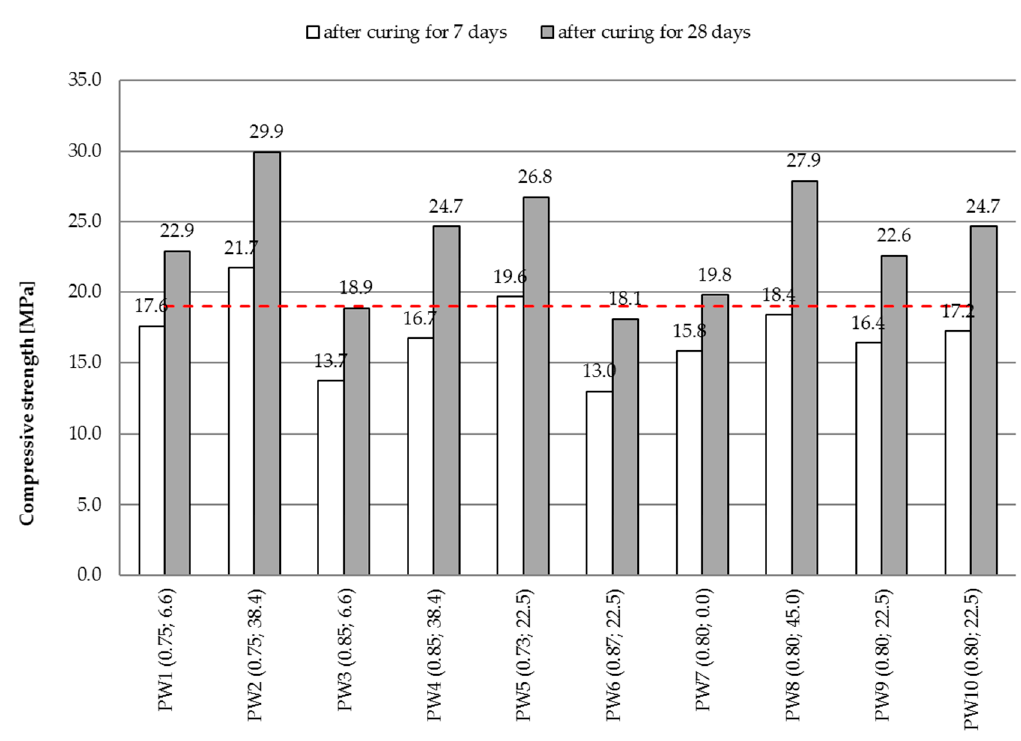
Figure 3. Compressive strength of concrete after curing for 7 and 28 days.